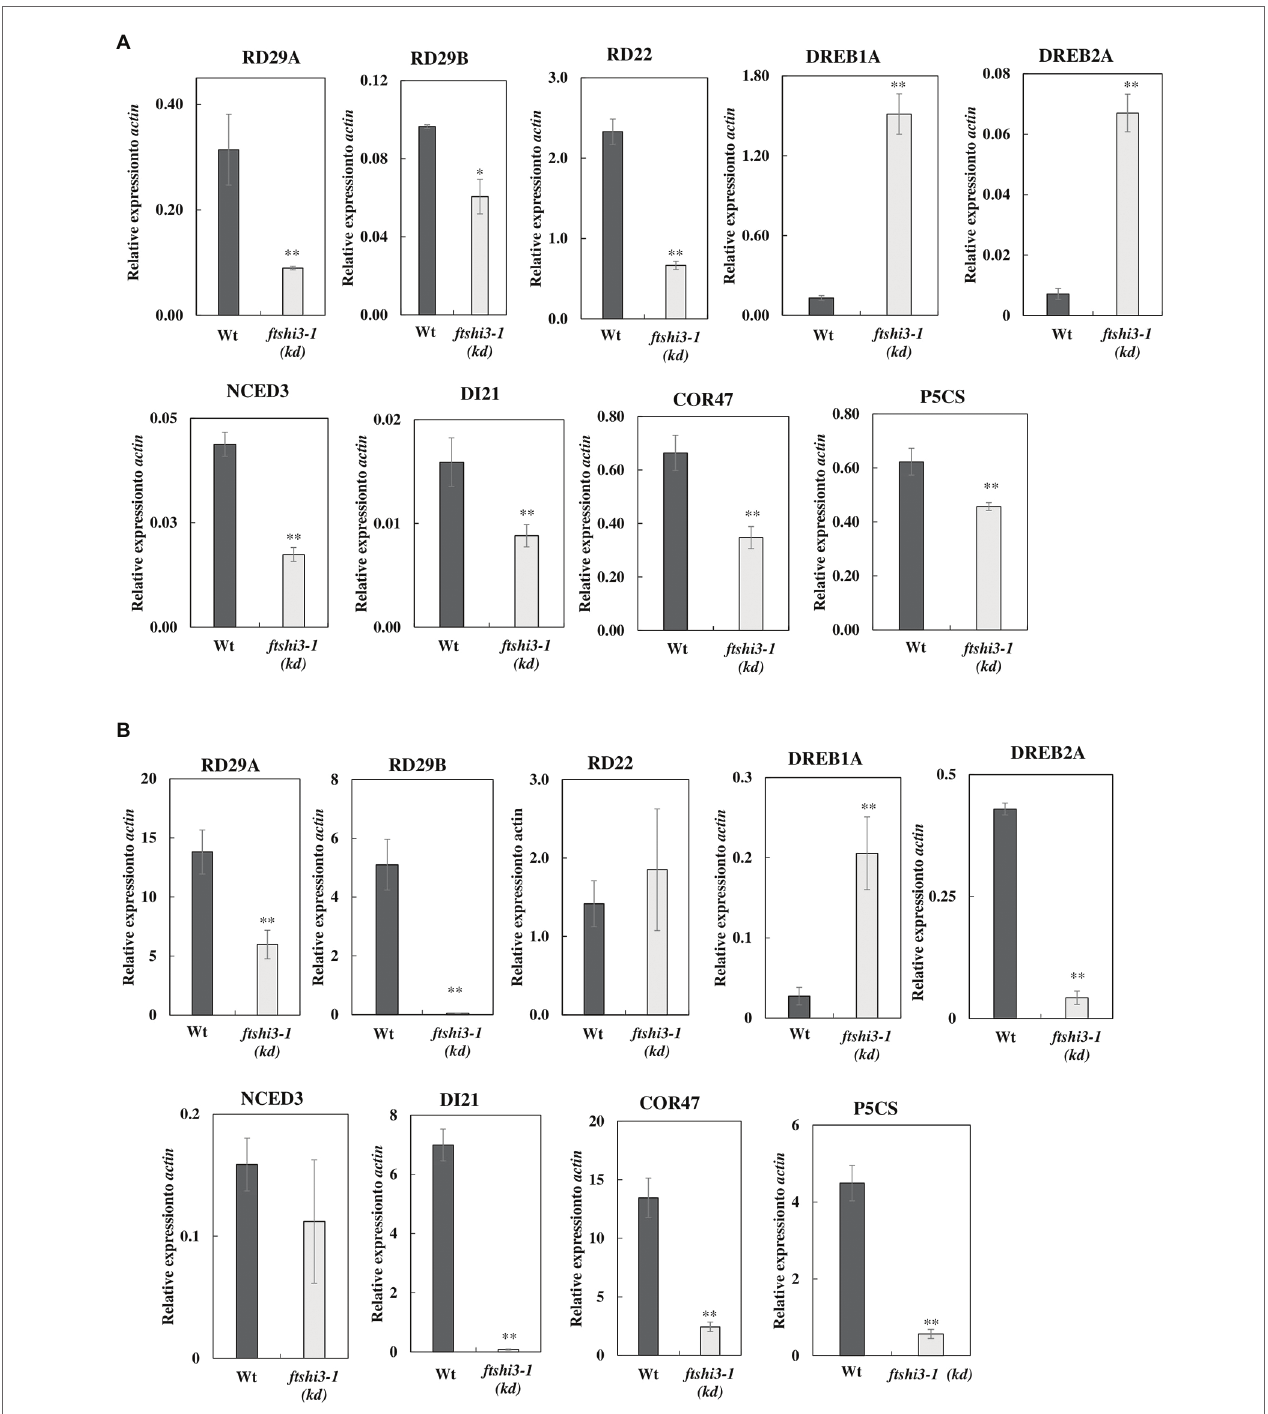
FIGURE 6 | (A) Relative expression of drought-responsive genes in ftshi3-1(kd) in watered conditions. The data were normalized to the expression of genes coding for Arabidopsis , actin . Asterisks indicate significant differences (Student’s t test, * p < 0.05; ** p < 0.001, n = 3). (B) Relative expression of drought-responsive genes under drought conditions for 14 days, normalized to the expression of actin . Asterisks indicate significant differences (Student’s t test, ** p < 0.001, n = 3). Error bars represent the